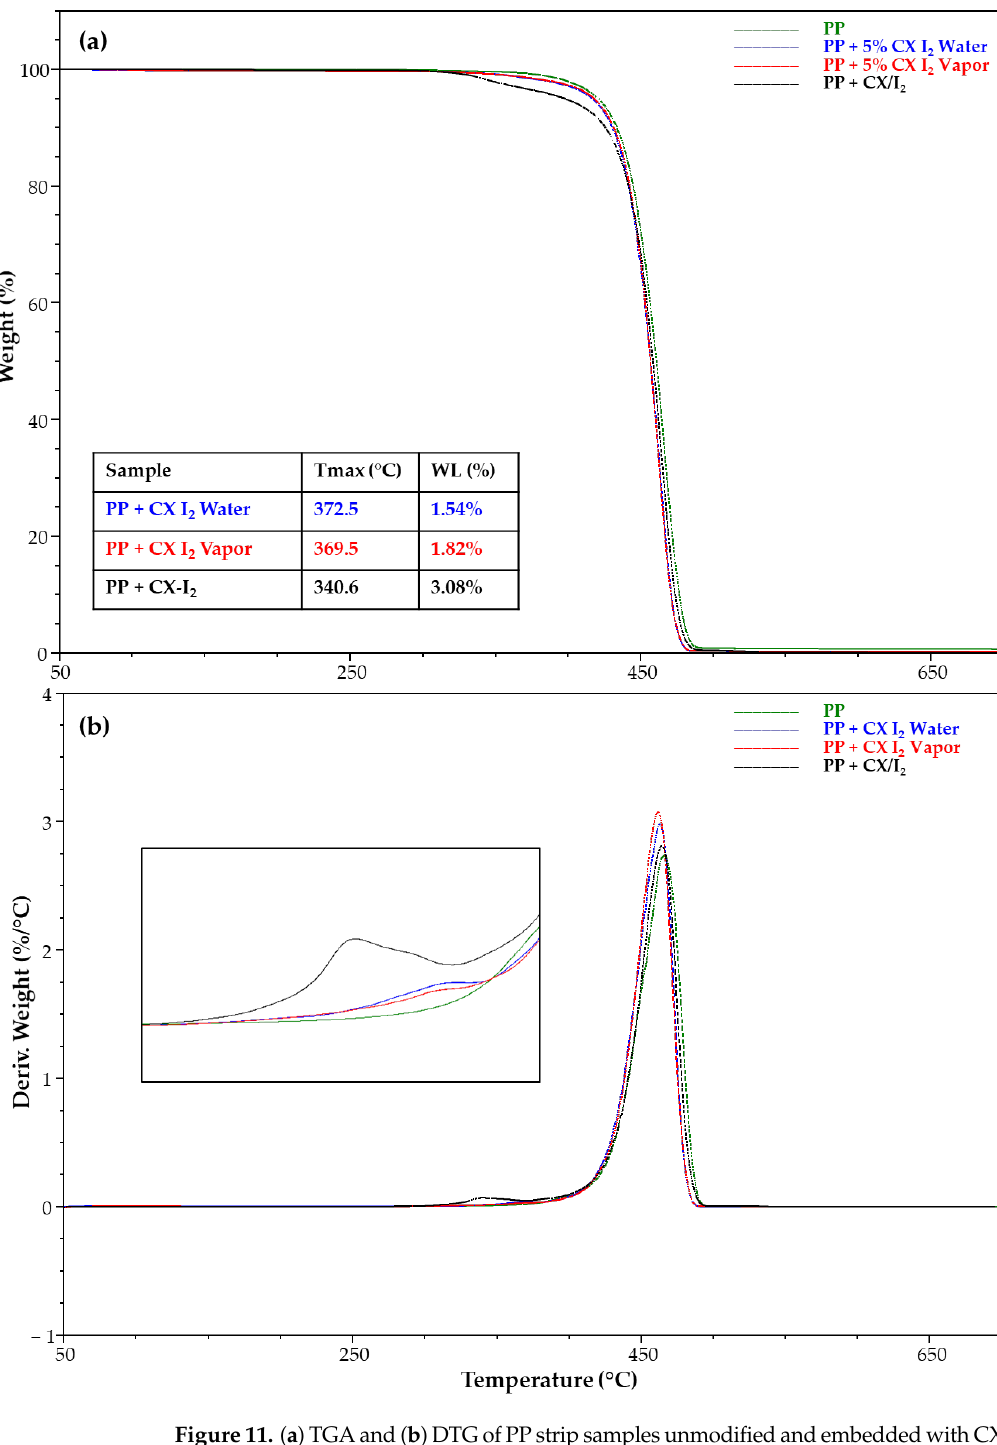
Figure 11. ( a ) TGA and ( b ) DTG of PP strip samples unmodified and embedded with CX iodine complex.